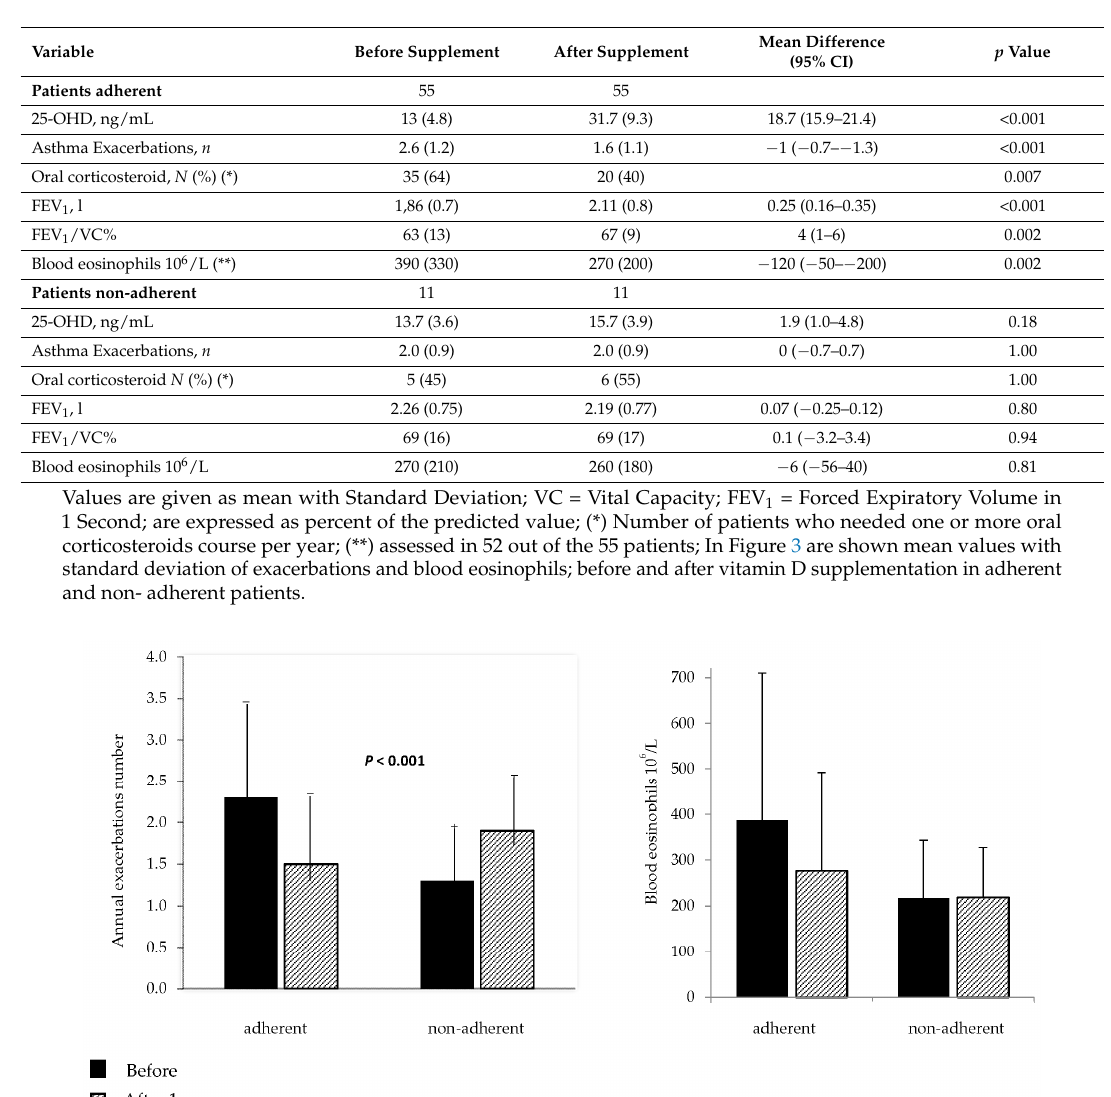
Table 3. 25-OHD, exacerbations, lung function tests and F E NO before and after vitamin D supplementation in the 55 patients adherent and in the 11 patients non-adherent to vitamin D supplementation.